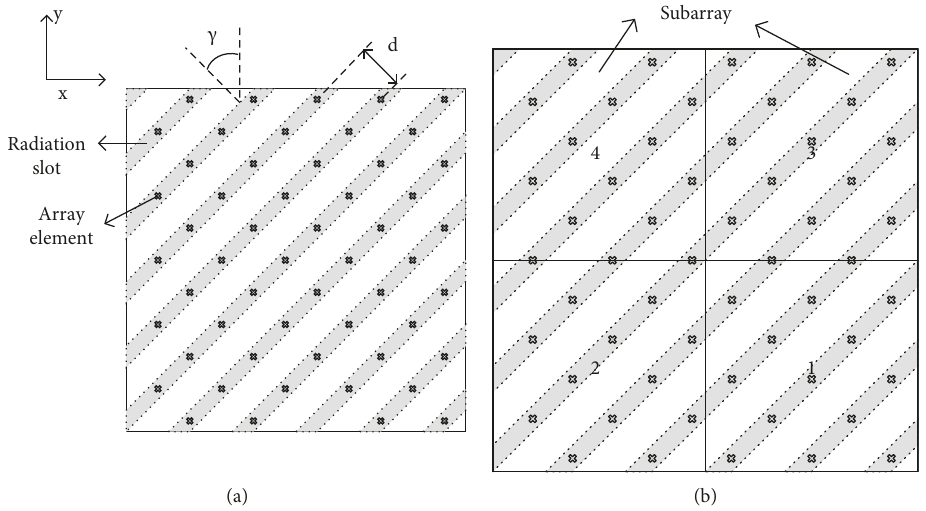
Figure 2: Rectangular array equivalent of (a) traditional and (b) proposed VICTS antennas.